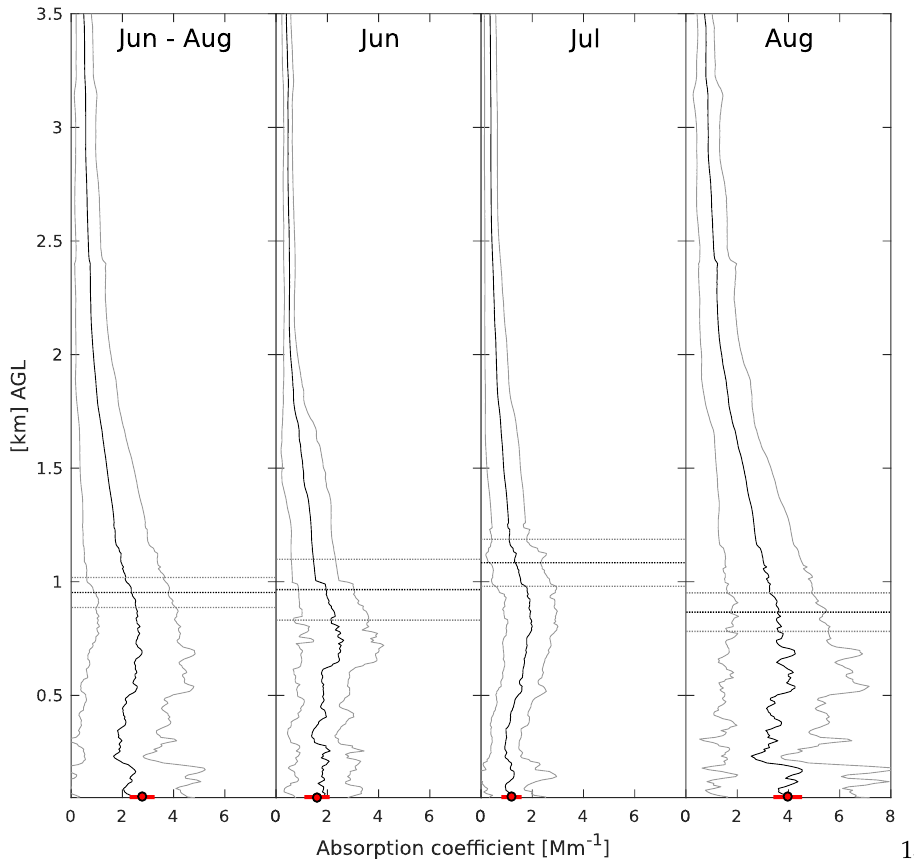
Figure 14. Averaged absorption coefficient profiles measured from UAS during summer campaign at SolarAOT site in 2015. Vertical grey lines indicate 95% confidence intervals for mean. Dotted lines represent PBL height with corresponding 95% confidence intervals. Ground values measured by aethalometer AE-31 are marked by red dots on axis with red lines as confidence